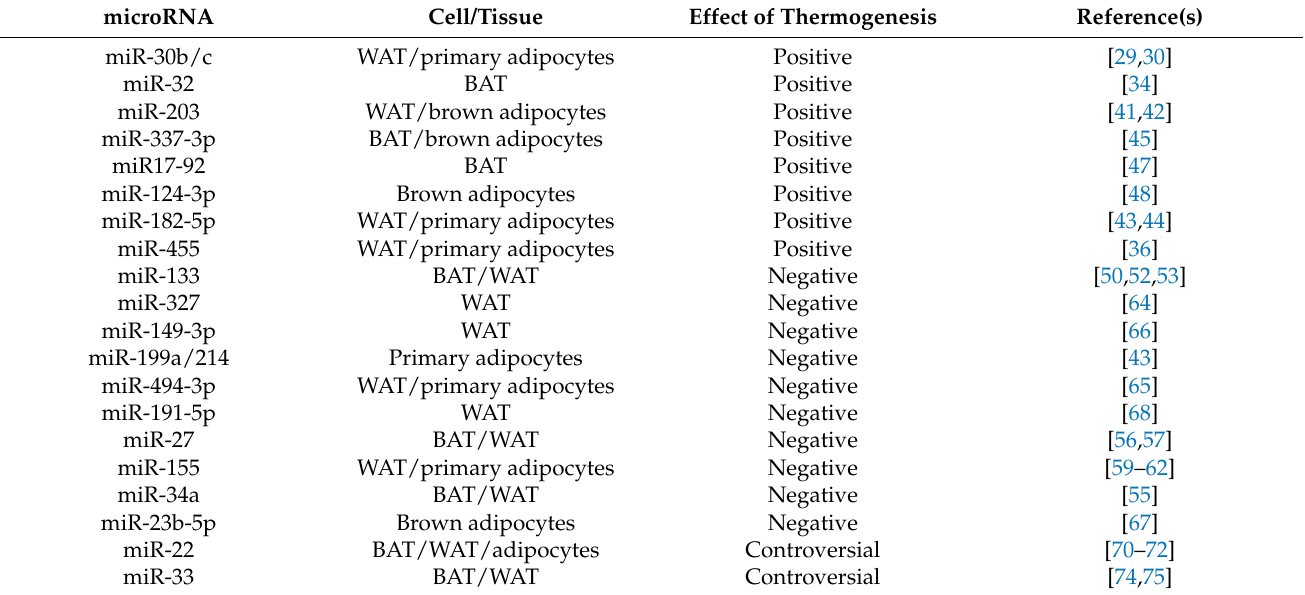
Table 1. Summary of miRNAs involved in adipose